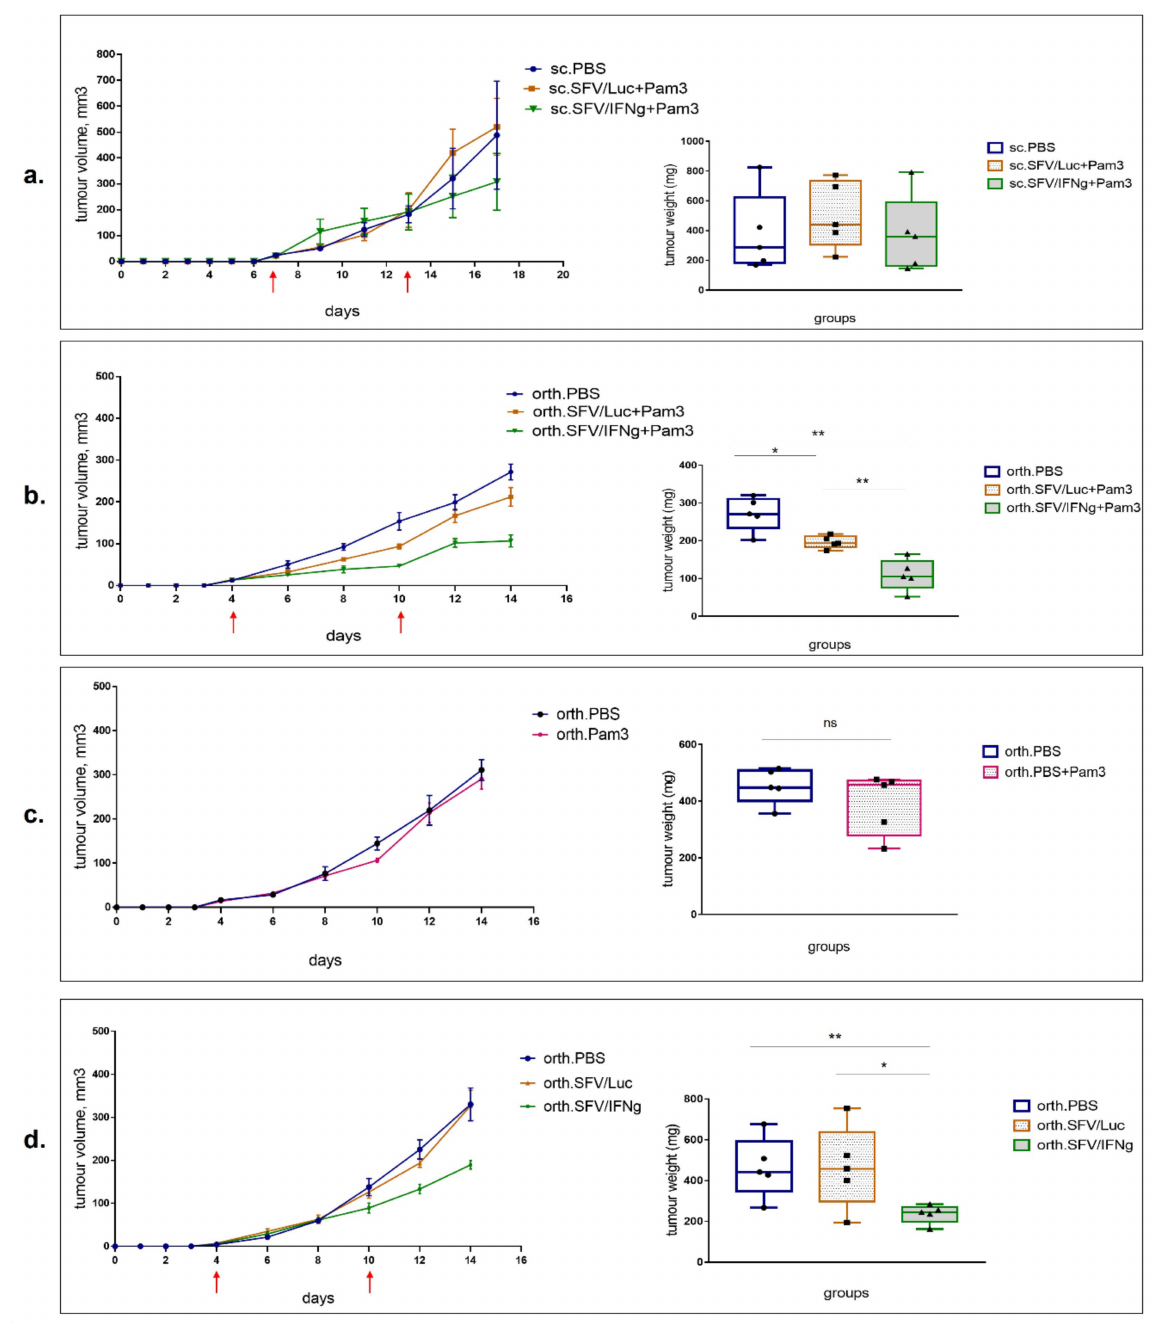
Figure 6. Inhibition of 4T1 tumor growth by i.t. injection of SFV/IFNg virus. The 4T1 mouse breast tumors were established by subcutaneous (sc.) or orthotopic injections of 2.5 × 10 5 and 1.25 × 10 5 4T1 cells, respectively. Mice received two i.t. injections of SFV vectors (4 × 10 7 i.u./tumor) or PBS control, as indicated by red arrow time points. The tumor growth curves are shown on the left and the tumor weights of the groups are shown on the right. ( a ) Treatment of subcutaneous tumors with SFV/IFNg, SFV/Luc, and PBS (control). The next day after virus administration, mice in these groups received i.t. injections of Pam3 solution (10 µ g/tumor at day 8 after first virus administration and 15 µ g/tumor at day 14 after second virus administration). ( b ) Treatment of orthotopic tumors with SFV/IFNg, SFV/Luc, and PBS (control). The day after virus administration, mice in these groups similarly received i.t. injections of Pam3 solution (10 µ g/tumor at day 5 after first virus administration and 15 µ g/tumor at day 11 after second virus administration). ( c ) Treatment of orthotopic tumors with only Pam3 (or PBS) solution: first Pam3 (10 µ g/tumor) i.t. injection at day 5; second Pam3 i.t. injection (15 µ g/tumor) at day 11. ( d ) Treatment of orthotopic tumors only with SFV/IFNg, SFV/Luc, and PBS (control), without the subsequent Pam3 injection. Bars represent the means ± SD ( n = 5); * p < 0.05; ** p < 0.01;